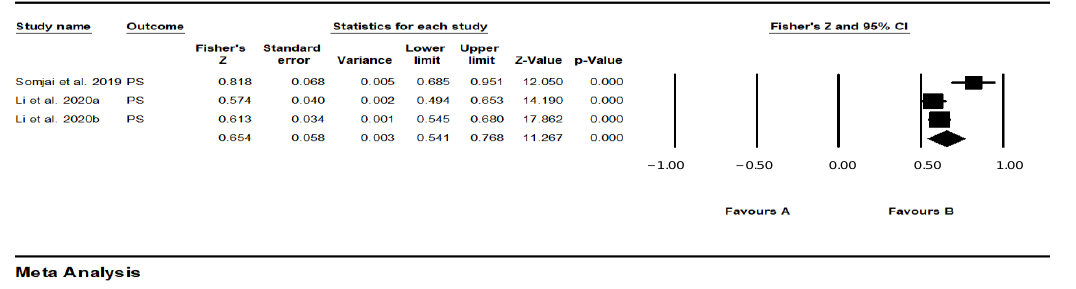
Figure 4. Forest plots.